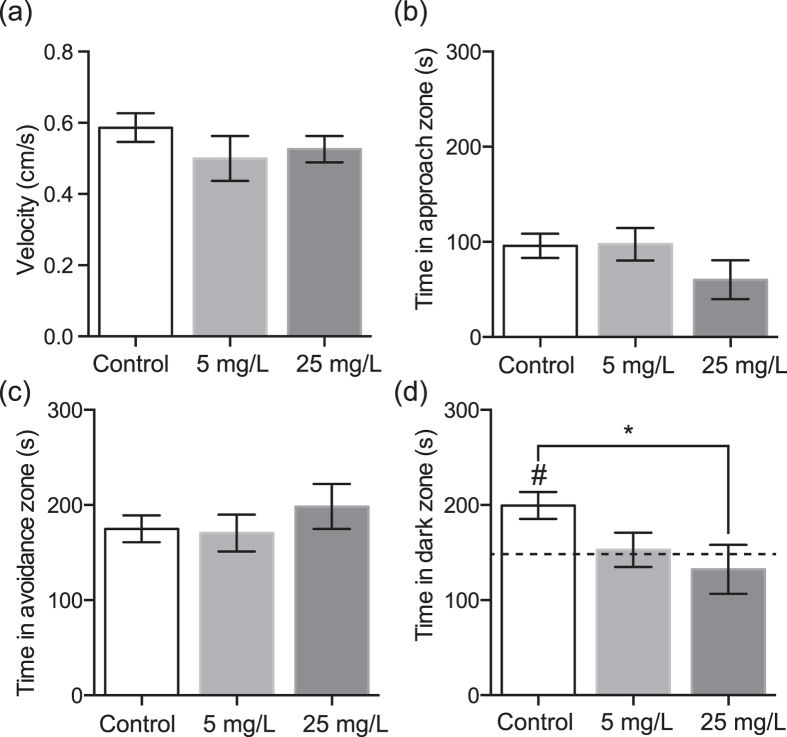
(a) Velocity during the open field test was not different between control and fluoxetine exposed groups (5 mg/L and 25 mg/L). (b) There were no significant differences between control and Fluox groups in the mirror-approach test for time in the approach zone, closest to the mirror, nor in the avoidance zone (c). (d) In the light/dark test only the control group had a significant dark preference (#, difference from 150, p = 0.0007). There was a significant difference between control and 25 mg/L Fluox groups (*p > 0.05).